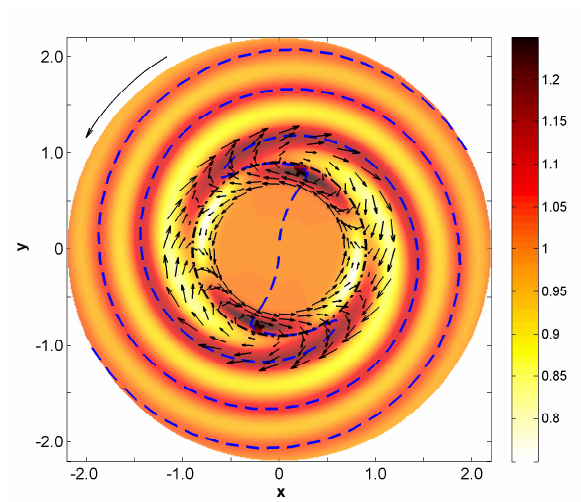
Figure 9. The perturbed surface density σ 1 ( r , φ ) for the unstable branch CF , the azimuthal harmonic m = 2, the parameter M * = 15. Case of the model disk with a uniform unperturbed surface density, and angular velocity profile (7), (8) with parameters (10), but with α Ω min = −2.0.